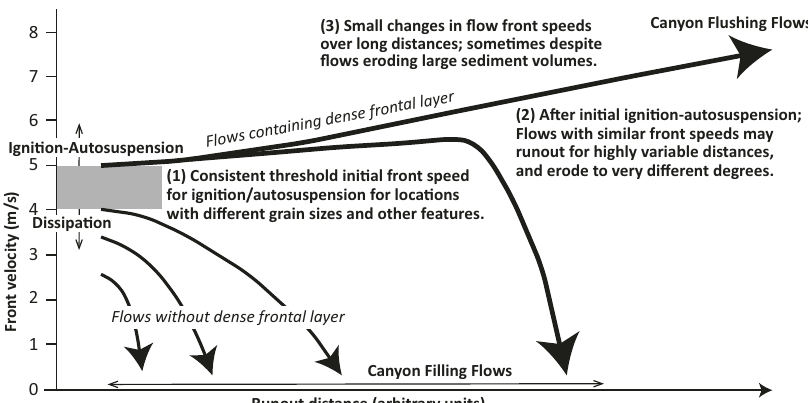
Fig. 8 Schematic diagram of changes in turbidity current front speed with distance, summarising key observations (labelled 1-to-3) that emerge from comparing fi eld data at four different locations (Fig. 7). Further details for these locations are provided by Supplementary Table 3. ( 1 ) There is a consistent threshold of initial front speed (4 – 5 m/s) needed for ignition or autosuspension in systems with variable sand-mud ratios, trigger mechanisms, input sediment fl ux, and other factors (Supplementary Table 3). ( 2 ) After fl ows have undergone ignition-autosuspension, fl ows with similar (5 – 8 m/s) front speeds can then runout for highly variable distances, and erode the seabed to different degrees. Flows in Congo Canyon ran out for >1100 km, and eroded the seabed to depths of 20 – 30 m (Fig. 6), while fl ows in Monterey Canyon with similar front speeds (Fig. 7) ran out for 50 km, causing sub-equal amounts of erosion and deposition to depths of only 2 – 3 m 34 . Flow-front speed can be a poor predictor of fi nal runout distance and seabed erosion, suggesting fl ows with similar fonts may have different bodies. ( 3 ) Flow-front speeds can have small fractional changes over long distances,